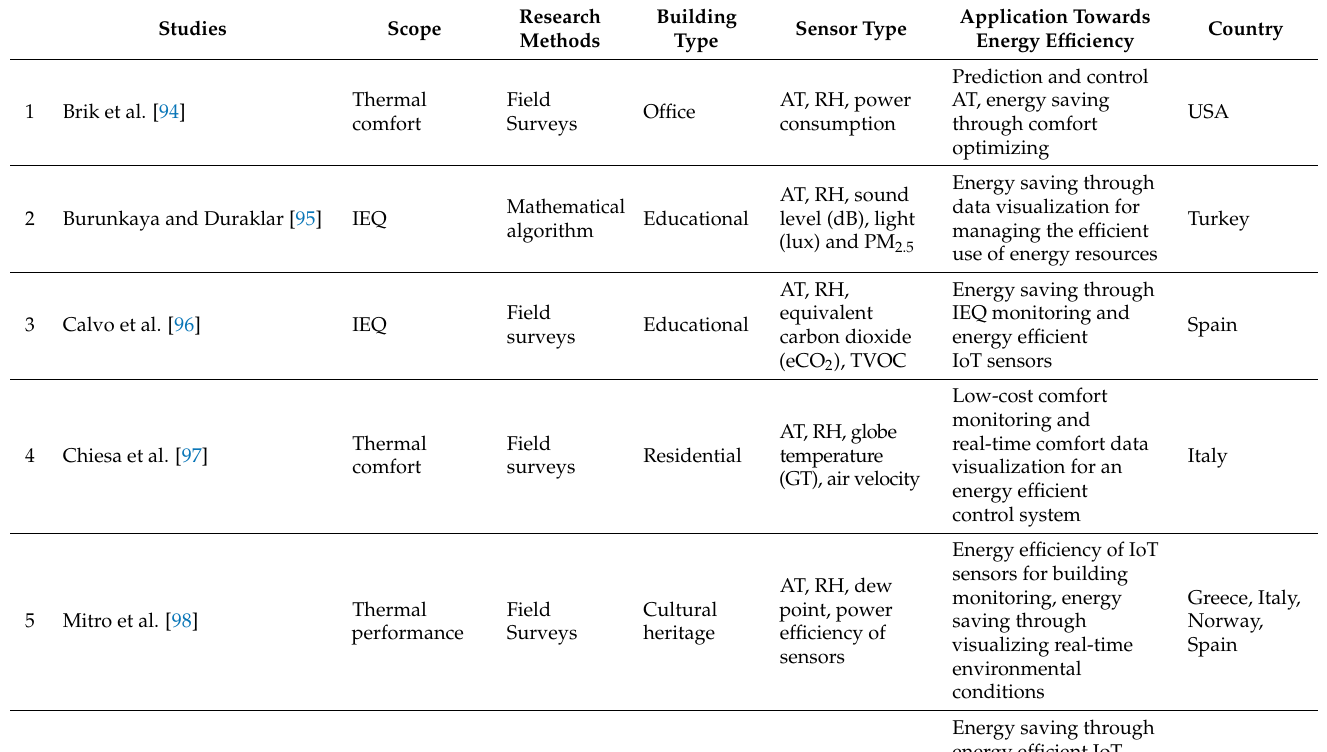
Table 3. Summary of recent studies on IoT-based building monitoring and IoT-based data visualiza- tion